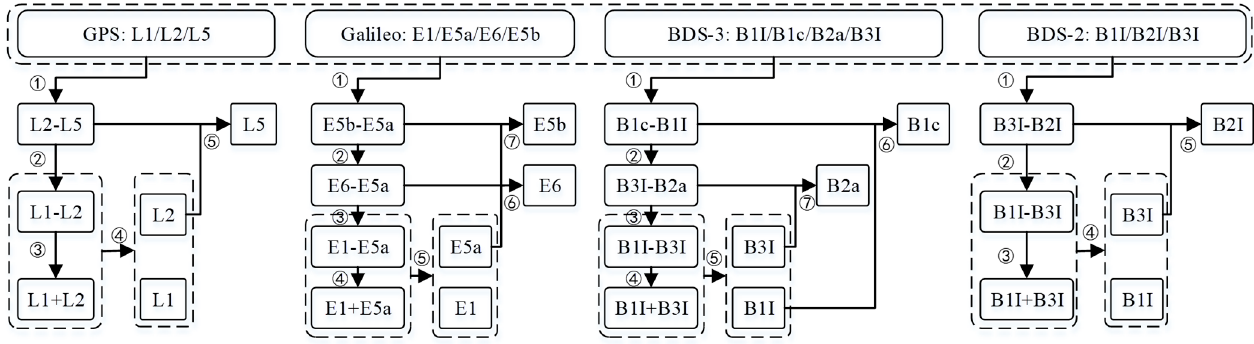
Figure 1. Flowchart of multi-frequency FCB estimation.